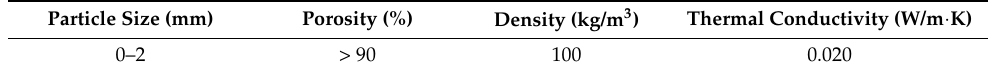
Table 4. Physical characteristics of SiO 2 aerogel.